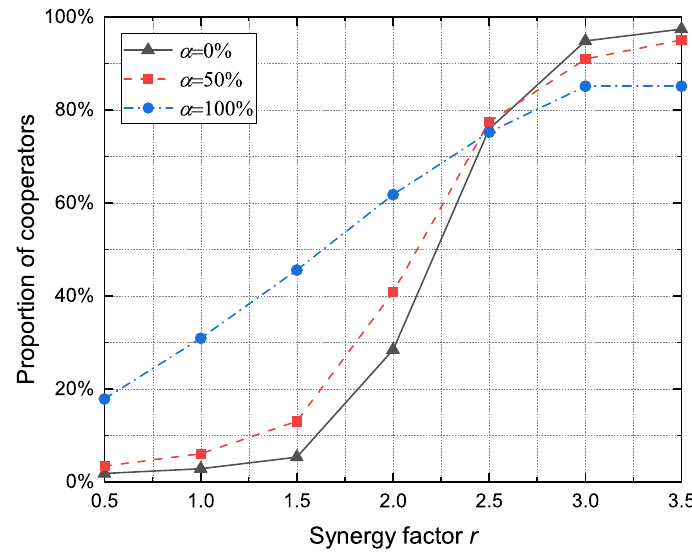
Figure 6. The proportion of cooperators under the different proportion of altruistic node α with respect to the synergy factor r .